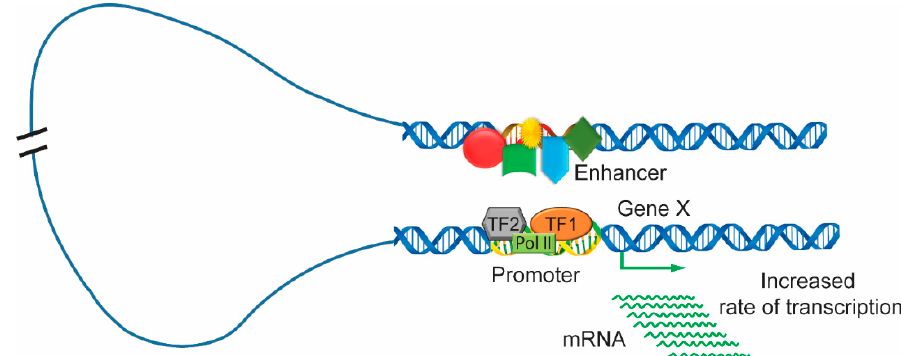
Figure 3. Looping between clusters of activators, mediators and transcription factors in enhancer and promoter regions. The enhancer region of chromatin is bound by the transcriptional complexes including various activators, mediators and transcription factors, which form enhancer clusters. The enhancer interacts with the promoter region, which combines with transcription factors and RNA polymerase to increase the rate of gene transcription.